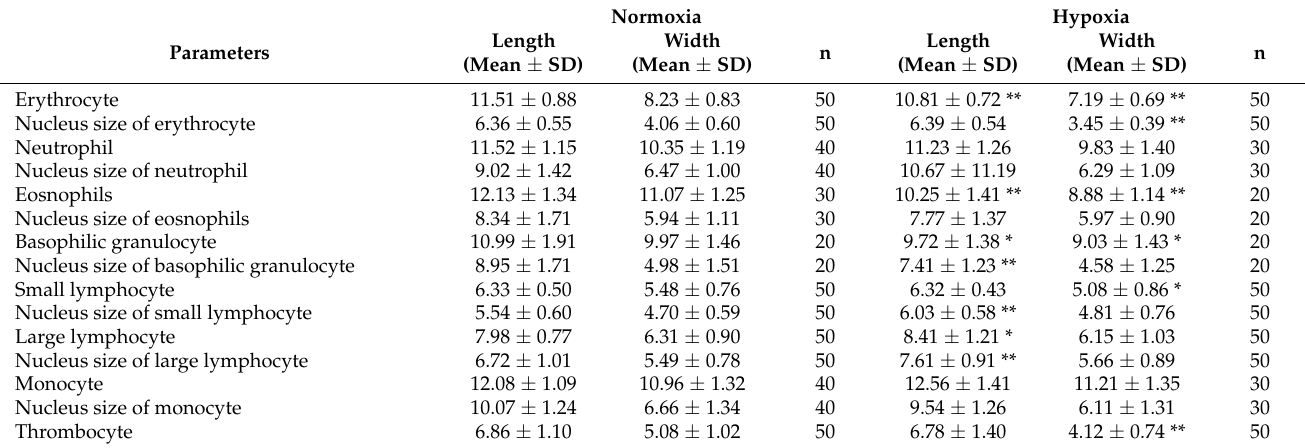
Table 2. The size of different types of blood cells in the two groups ( μ m).